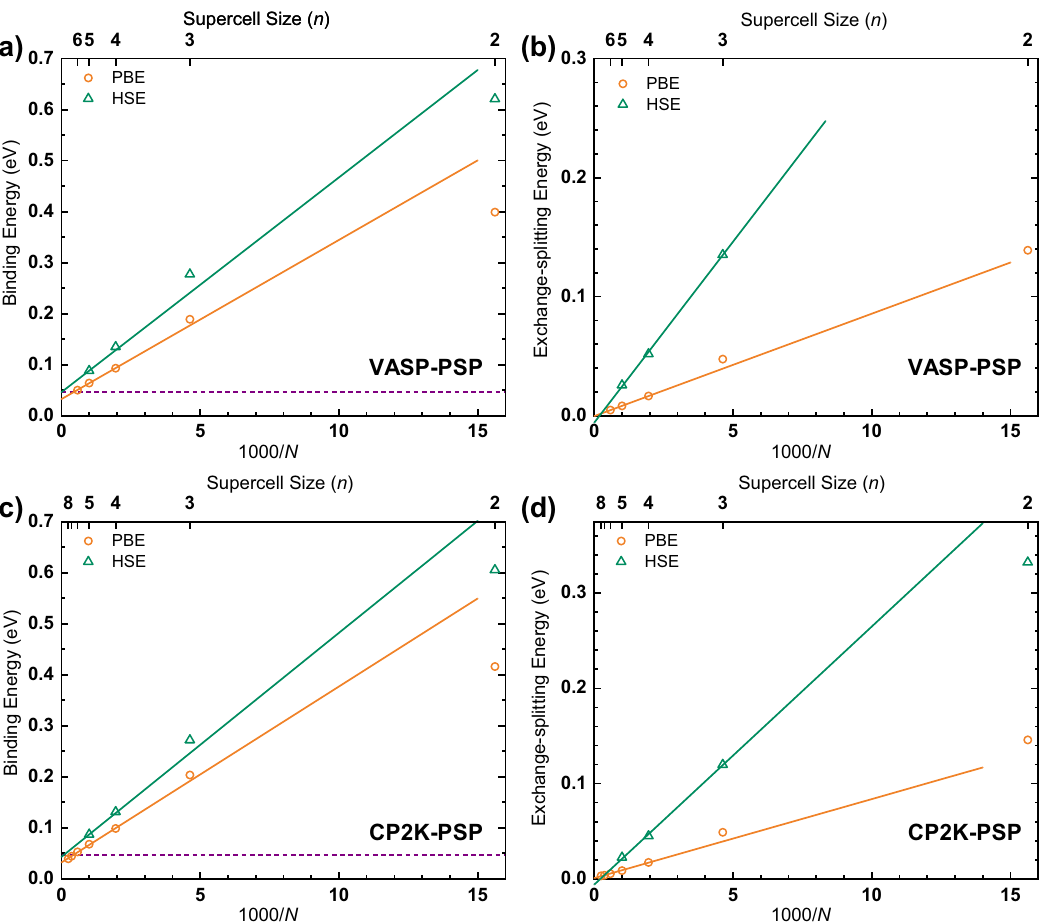
Fig. 5 Binding energy and exchange-splitting energy. The calculated binding energy and exchange-splitting energy for a single phosphorus donor in silicon as a function of supercell size: a , b Pseudopotential approximation approach using VASP (VASP-PSP); c , d Pseudopotential approximation approach using CP2K (CP2K-PSP); dashed line represents the experimental value of binding